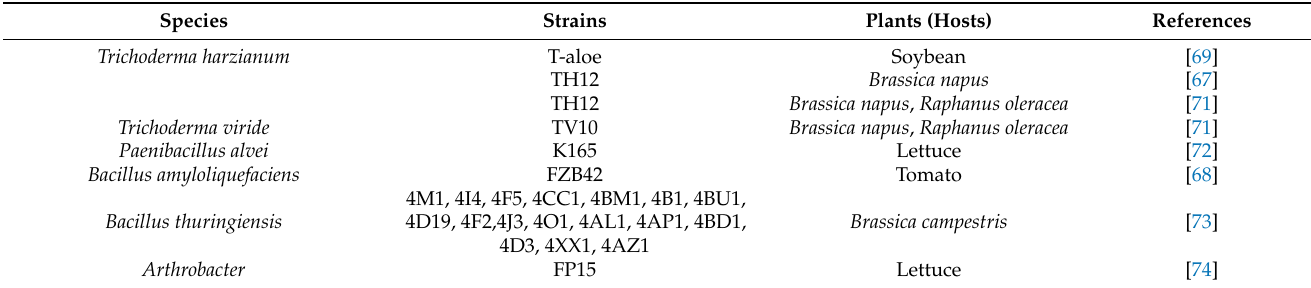
Table 2. Microbial strains inhibiting S. sclerotiorum through induced systemic